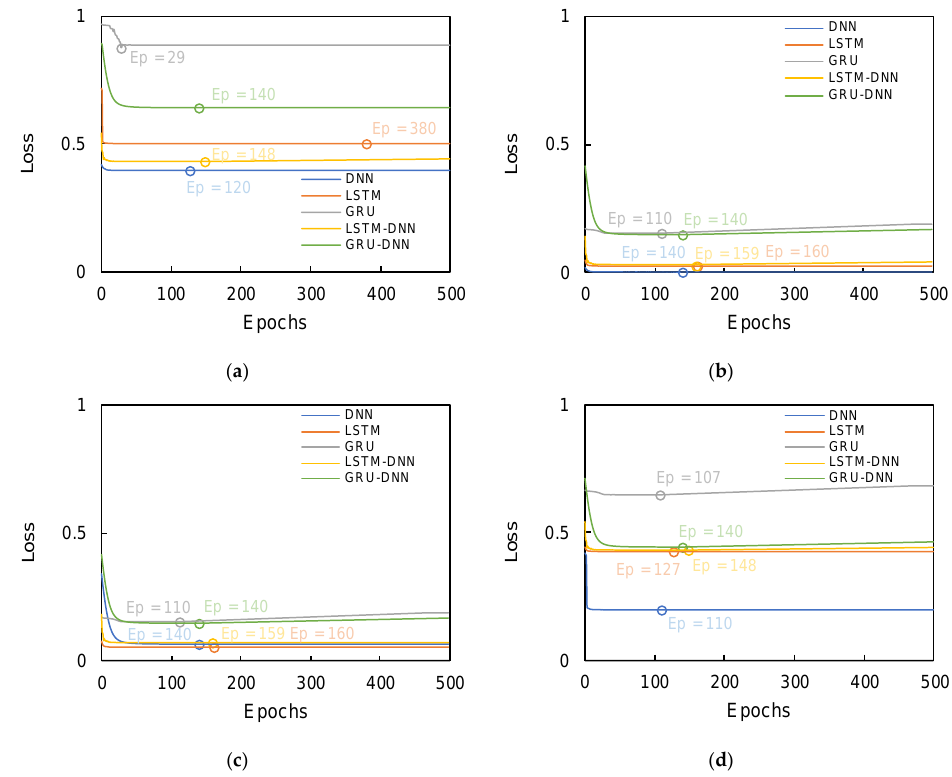
Figure 5. Results of loss based on ratio of training, validation and test data: ( a ) 7:2:1; ( b ) 6:2:2; ( c ) 5:2:3; ( d ) 4:2:4. The hollow circles denote the optimal epochs. Table 1. Distribution of best epochs with loss based on the ratio of training, validation, and test data. The DNN, LSTM and GRU denote deep neural network, long-short term memory, gated recurrent unit, respectively. The LSTM-DNN and GRU-DNN show coupled algorithms based on DNN with LSTM and